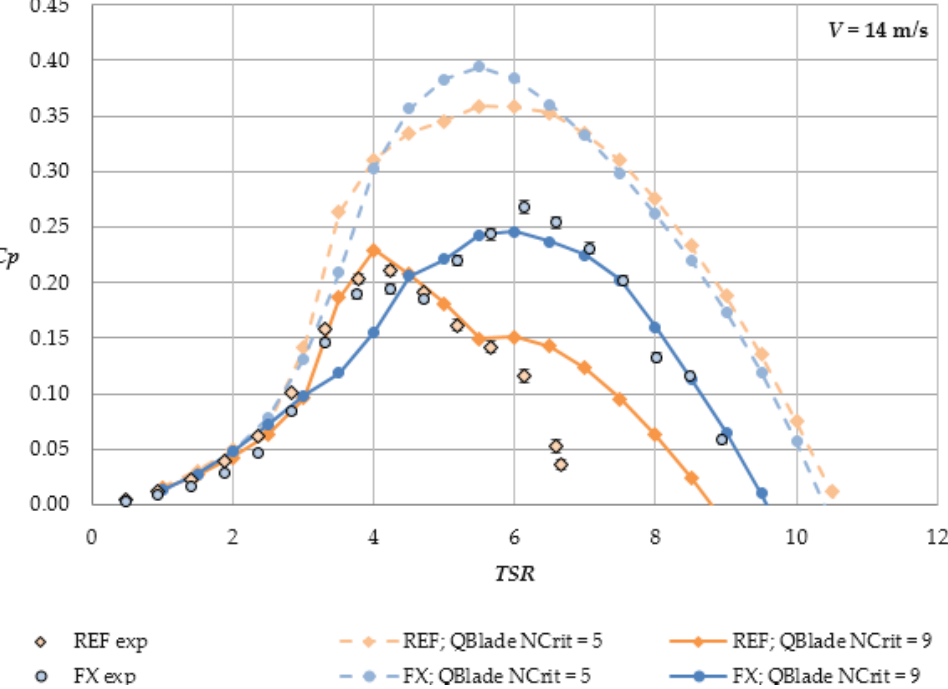
Figure 10. Results of the experiment compared with the numerical predictions for scaled models at the wind speed of 14 m/s; measurement uncertainty included.